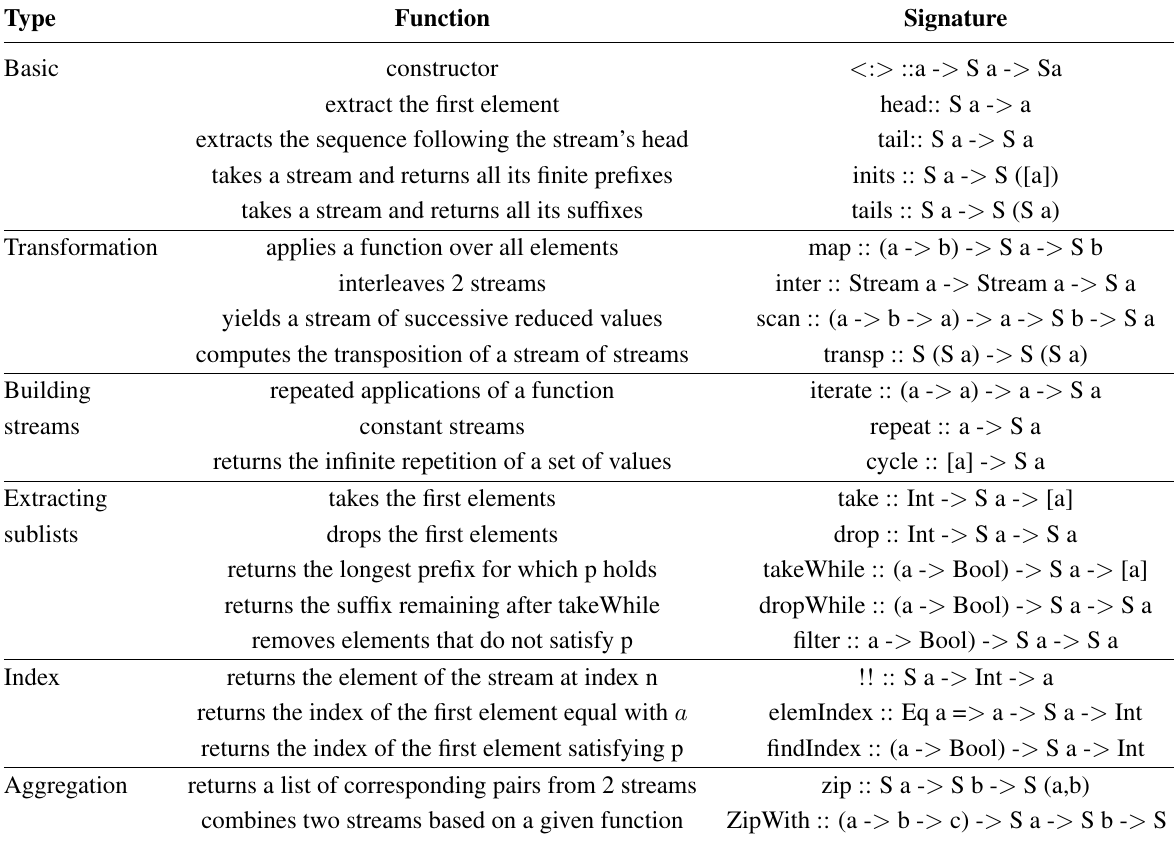
Table 2. Stream operators in Haskell ( S stands for the Stream